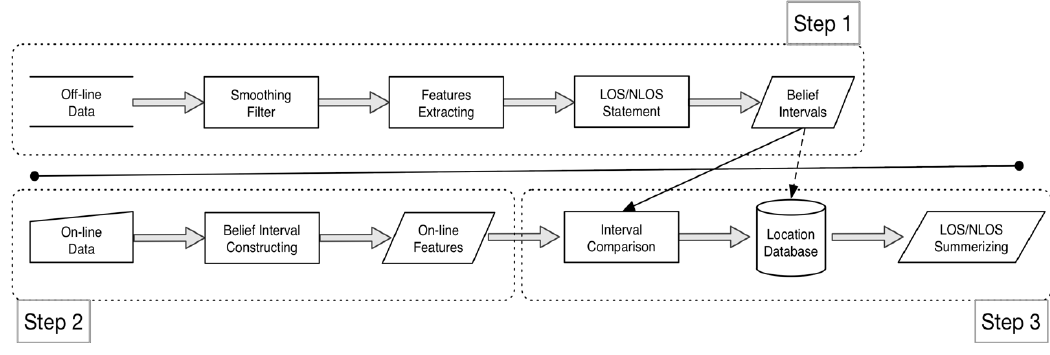
Figure 4. The proposed system structure.